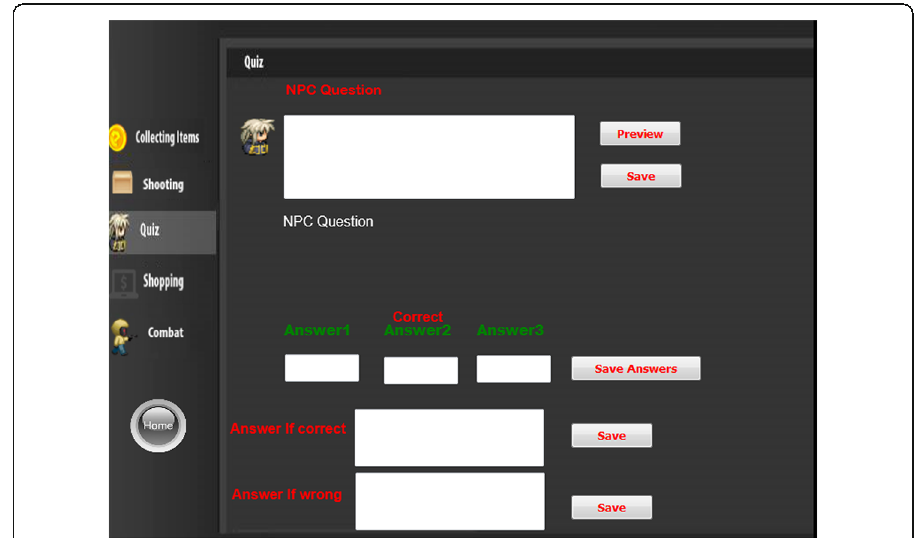
Fig. 2 Game interface to manage the learning content of the “ quiz ” game